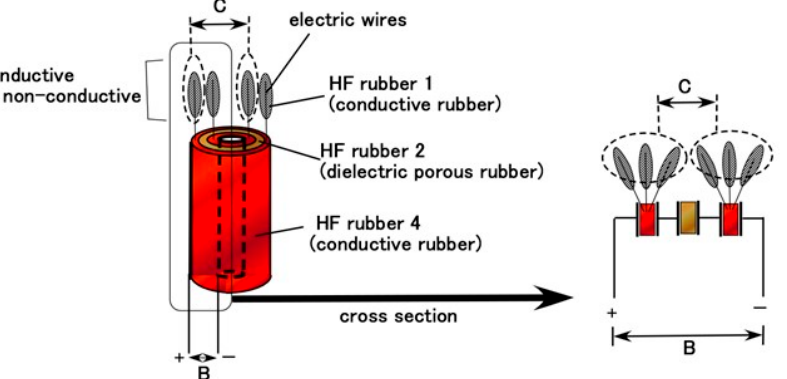
Figure A2. Schematic diagrams of equivalent electric circuit of cylindrical-type Pacinian corpuscles for gustatory receptor [23].